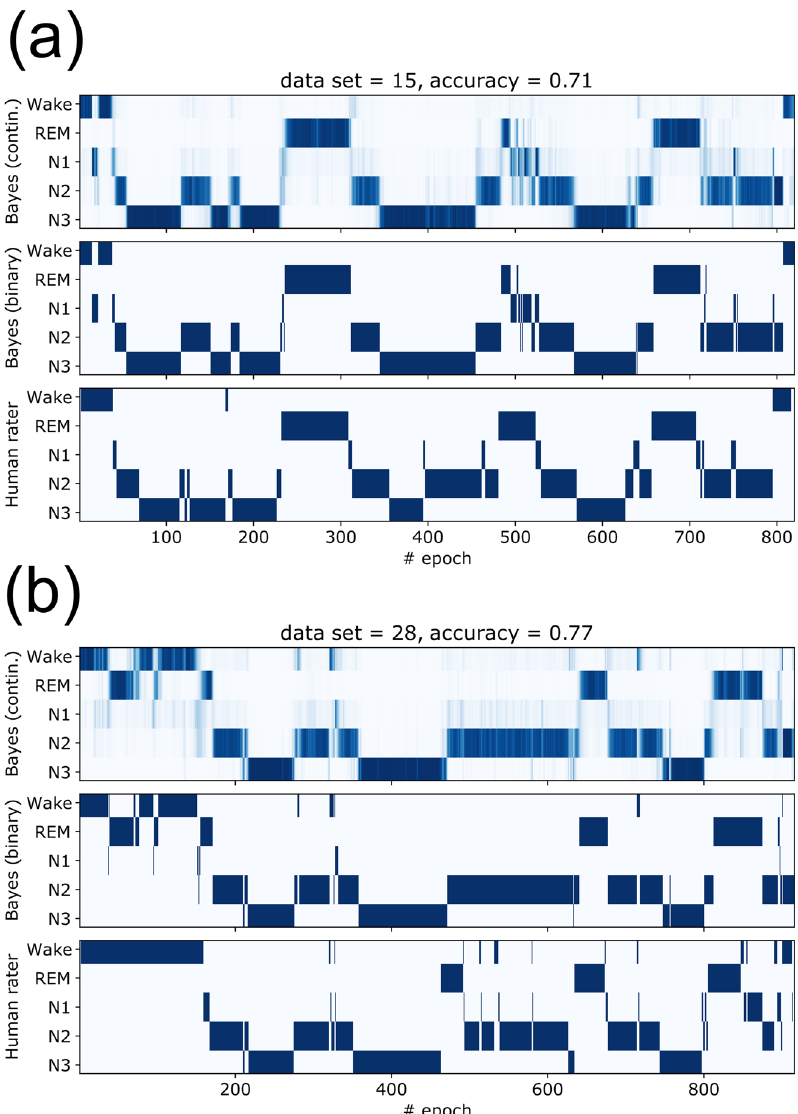
Fig. 6 Bayesian sleep-stage classi fi cation. a , b Two examples of automated Bayesian sleep stage classi fi cation. In each case, the upper hypnogram shows, for each 30 s epoch, the posterior probabilities of the sleep stages, with larger color density corresponding to larger probability. The middle hypnogram shows only the predicted sleep stage with maximum posterior probability. The lower hypnogram is the ground truth, provided by the specialist human rater. The accuracies are de fi ned as the ratio of correct sleep stage